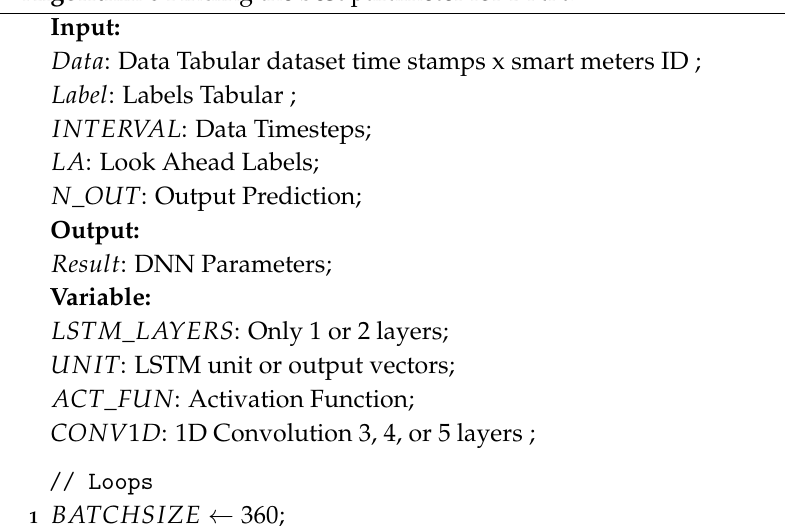
Algorithm 6 Finding the best parameter for